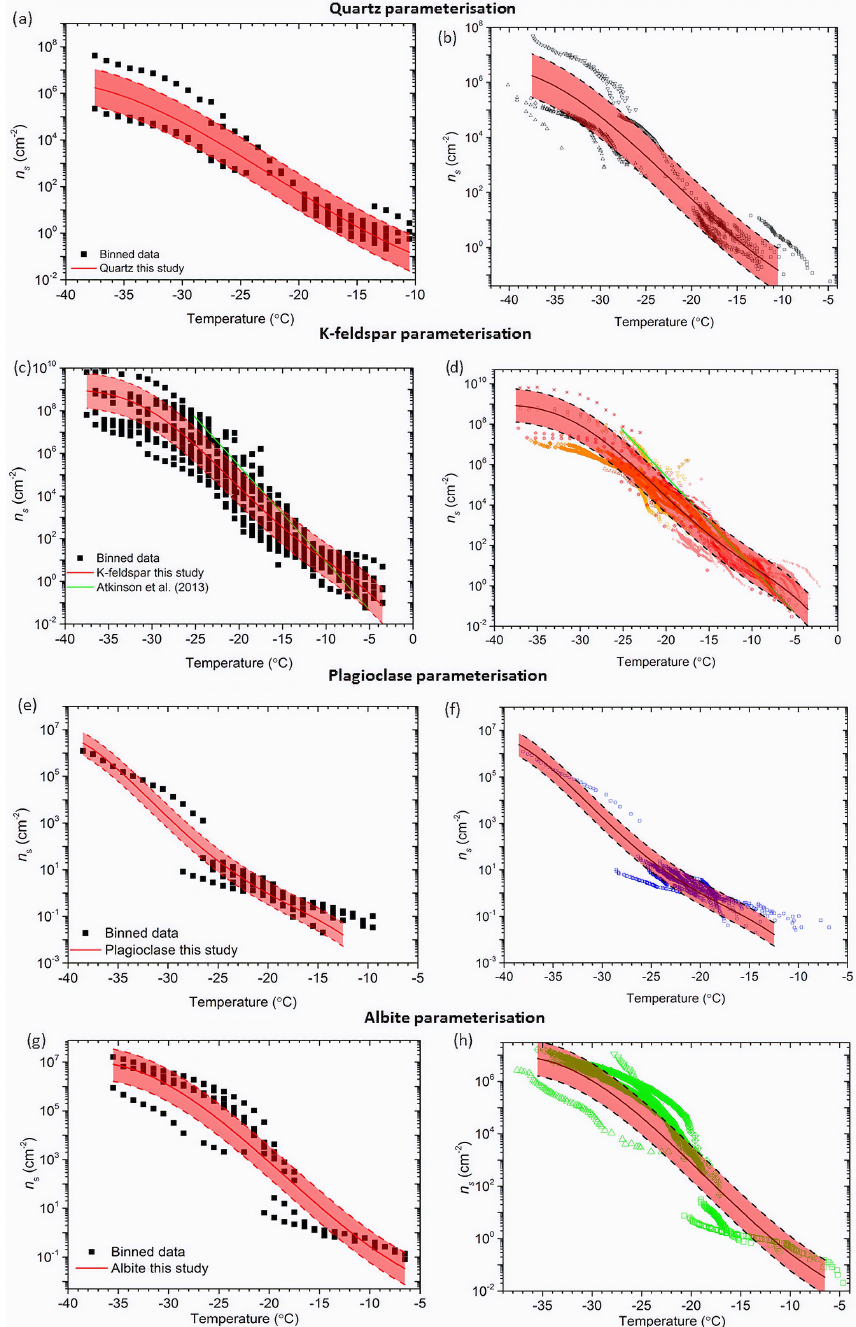
Figure 7. Parameterizations developed for various silicate minerals. Panels (a) , (c) , (g) and (e) show the temperature-binned n s data used to derive the parameterizations. Panels (b) , (d) , (f) , and (g) show the new parameterizations plotted with the orig- inal non-binned data. The standard deviation is highlighted in the red-shaded area for each parameterization. The green line in panel (d) indicates the K-feldspar parameterization from Atkinson et al. (2013). See Fig. 6 for the sources of the raw data. The new parameterizations (validity T ranges and standard deviation for log( n s ( T )), where n s is in units of cm − 2 , are as follows. Quartz: log( n s ( T )) =− 1.709 + (2 . 66 × 10 − 4 T 3 ) + (1 . 75 × 10 − 2 T 2 ) + (7 × 10 − 2 T ), ( − 10.5 to − 37.5 ◦ C; 0.8);